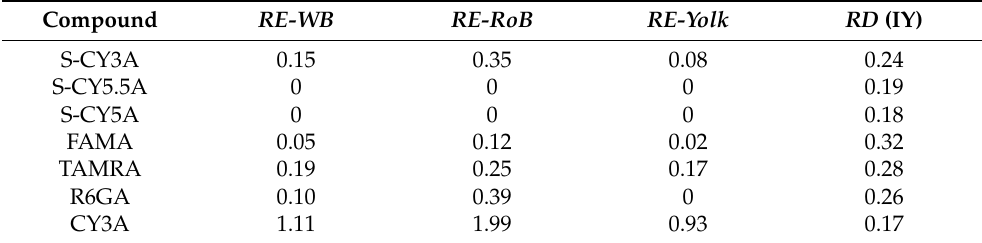
Table 2. Relative exposure ( RE ) values ( WB : whole body, RoB : rest of body) in the case of immersion and intrayolk microinjection and relative distribution ratio ( RD ) after microinjection. Compound RE-WB RE-RoB RE-Yolk RD (IY) S-CY3A 0.15 0.35 0.24 S-CY5.5A 0 0 0.19 S-CY5A FAMA TAMRA